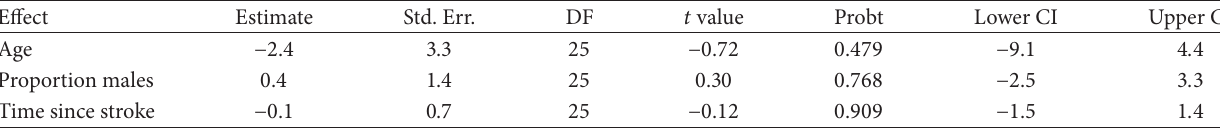
Table 4: Meta-regression coefficients for 30 m protocol subgroup.